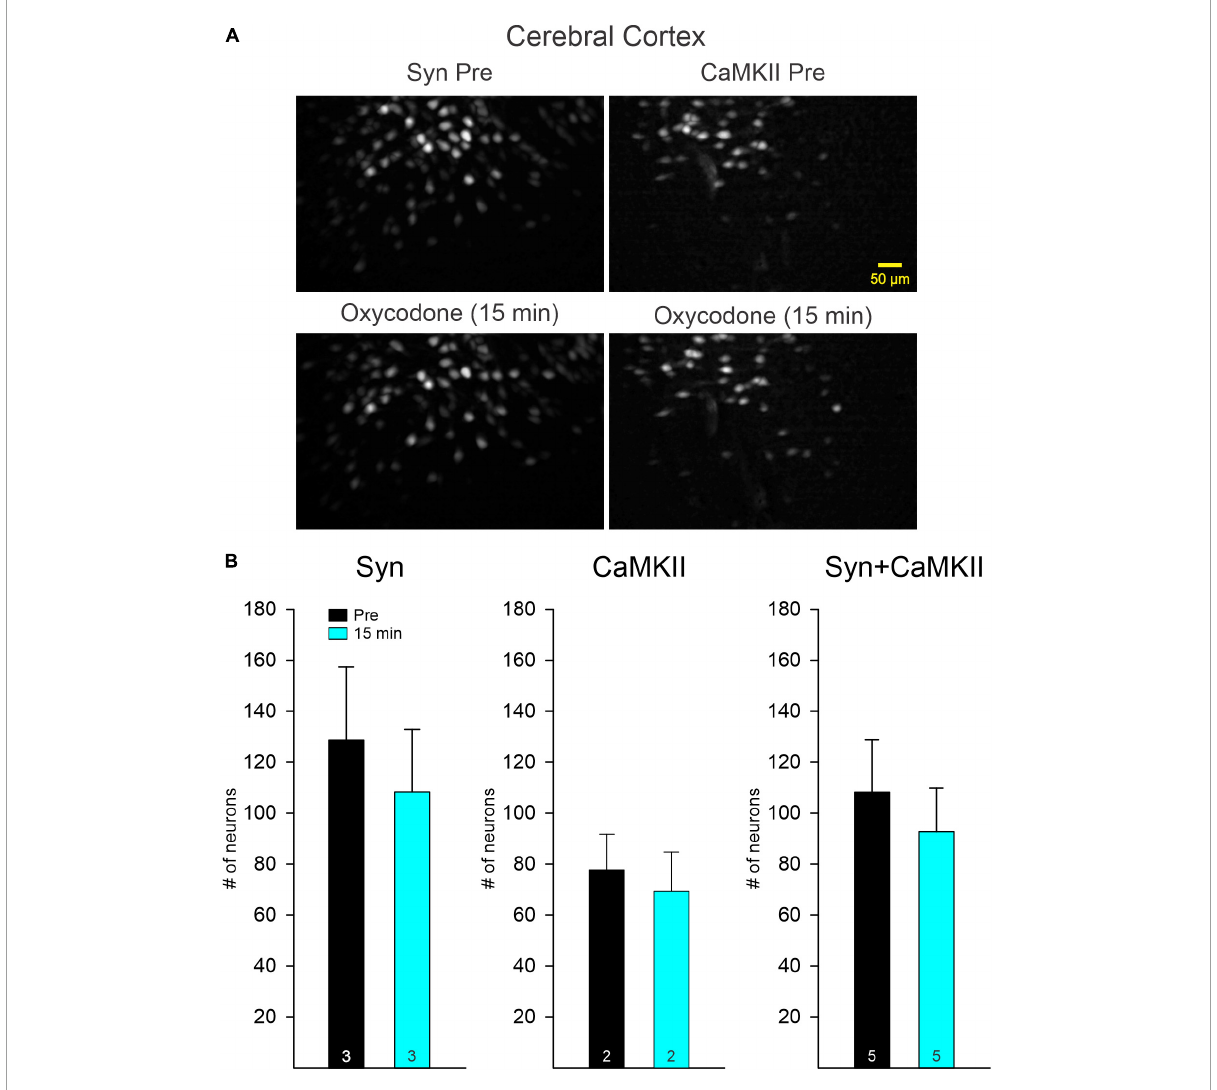
FIGURE4 (A) Maximum intensity projection panels illustrate fluorescent cortical pyramidal neurons (CPNs), Syn (left), and CaMKII (right), visualized with the aid of a Miniscope in Pre conditions and 15 min after IP injection of oxycodone. The number of CPNs did not seem to change